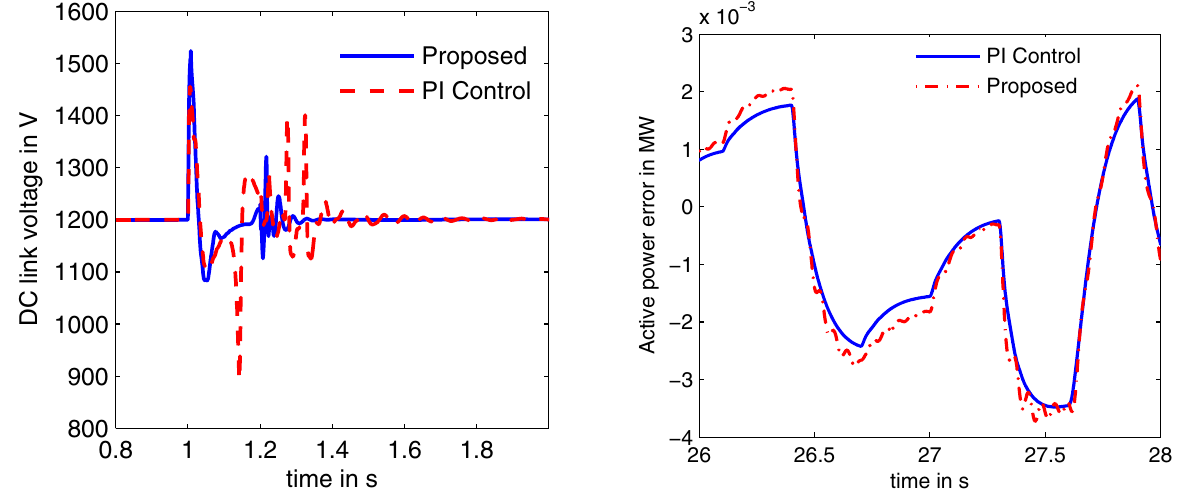
Fig. 14 Active power error for variable wind